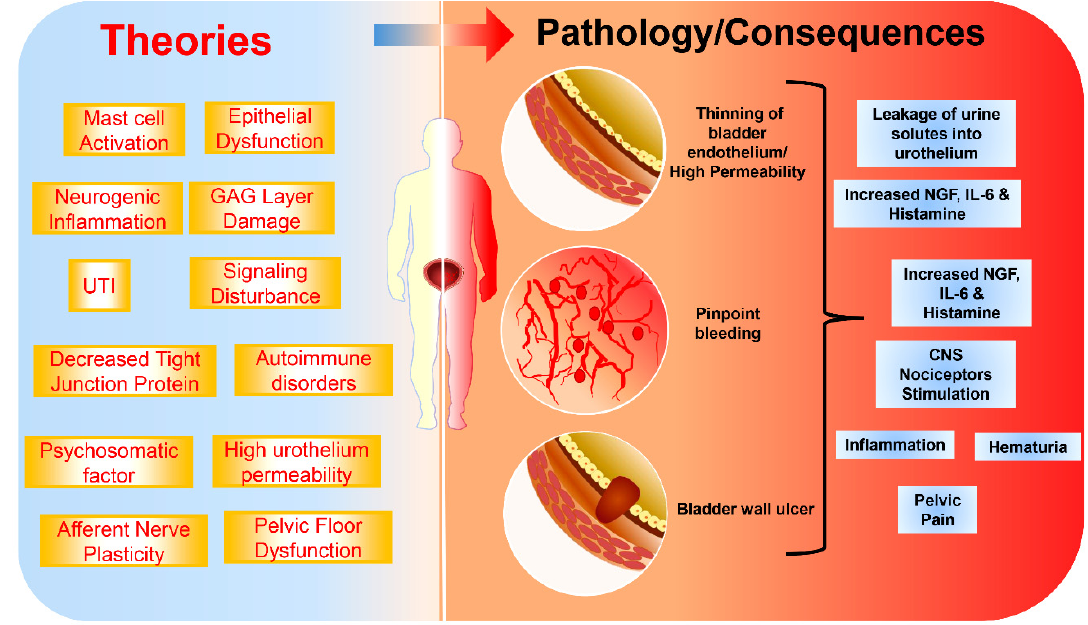
/ bladder pain syndrome (IC /